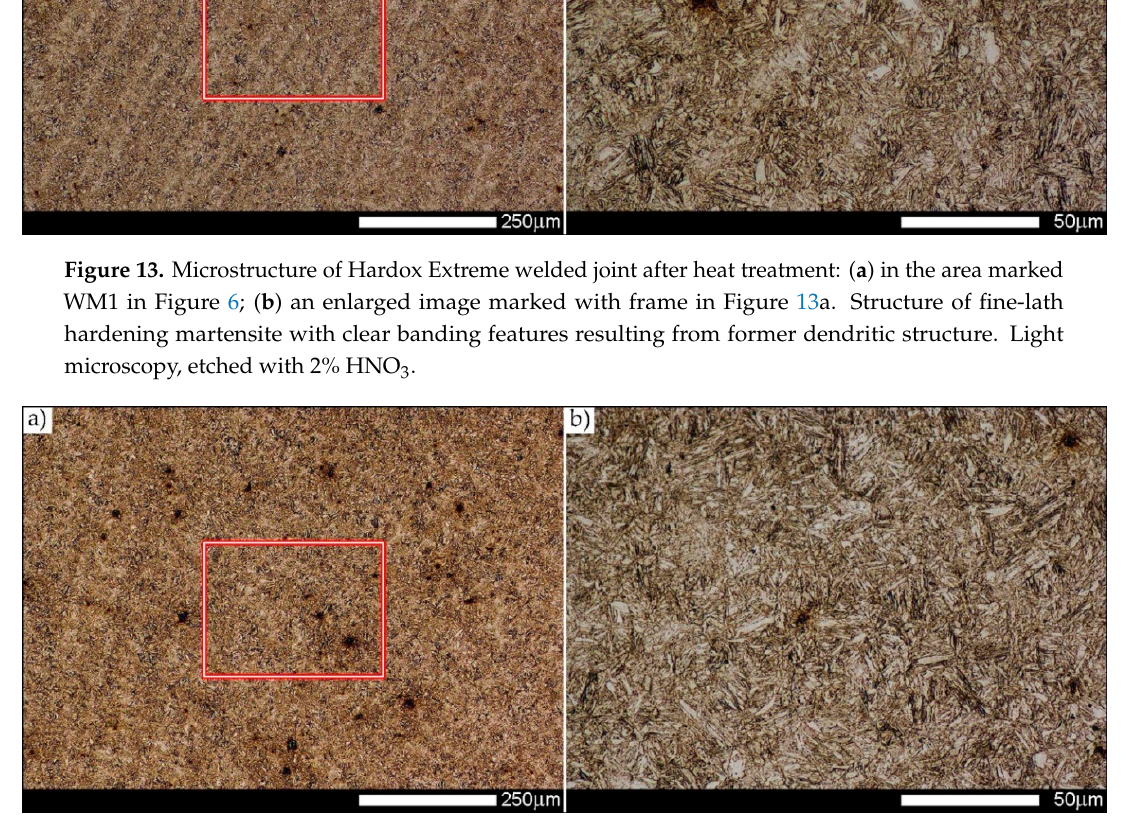
Figure 14. Microstructure of Hardox Extreme welded joint after heat treatment: ( a ) in the area marked WM2 in Figure 6; ( b ) an enlarged image marked with frame in Figure 14a. Structure of fine-lath hardening martensite. Light microscopy, etched with 2% HNO 3 .